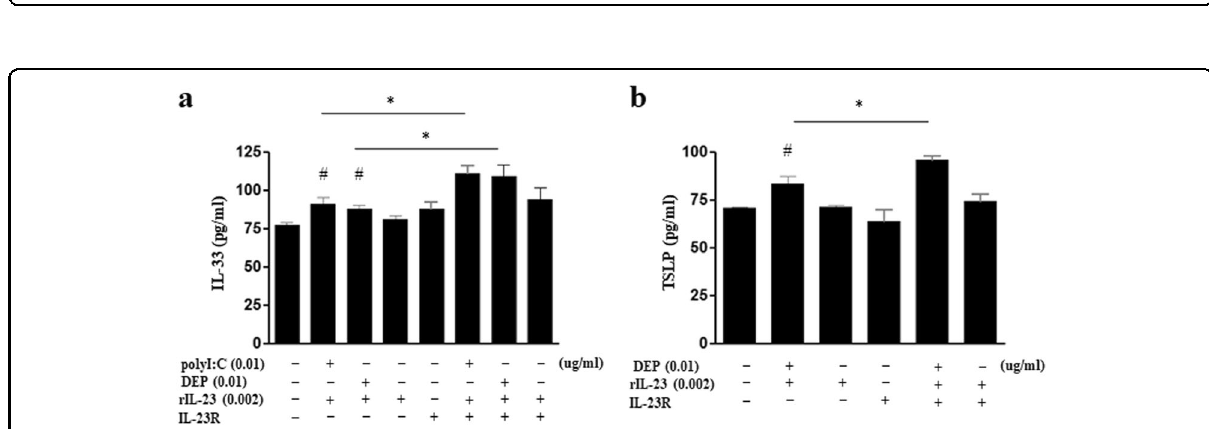
Fig. 7 Effects of IL-23R overexpression in MLE12 cells treated with polyI:C/rIL-23 or DEP/rIL-23. a IL-33 levels in the nuclei of MLE12 cells. b TSLP levels in the cytosol of MLE12 cells. * P < 0.05 between two groups; # P < 0.05 compared to medium only; DEP diesel exhaust